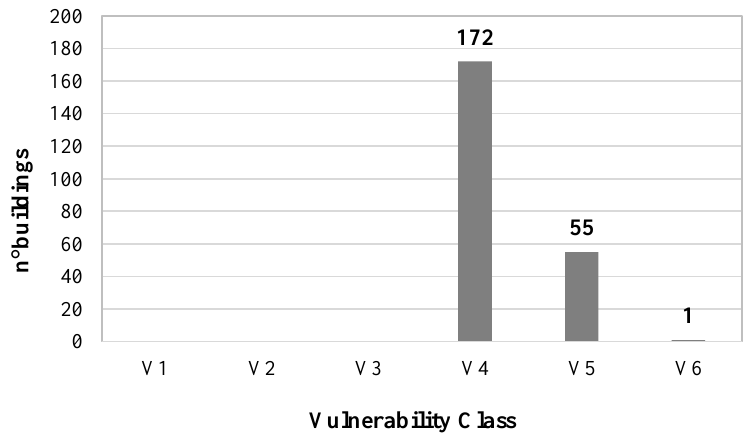
Figure 11. Vulnerability class for 228 masonry buildings according to the DM 58 / 17 simplified method.